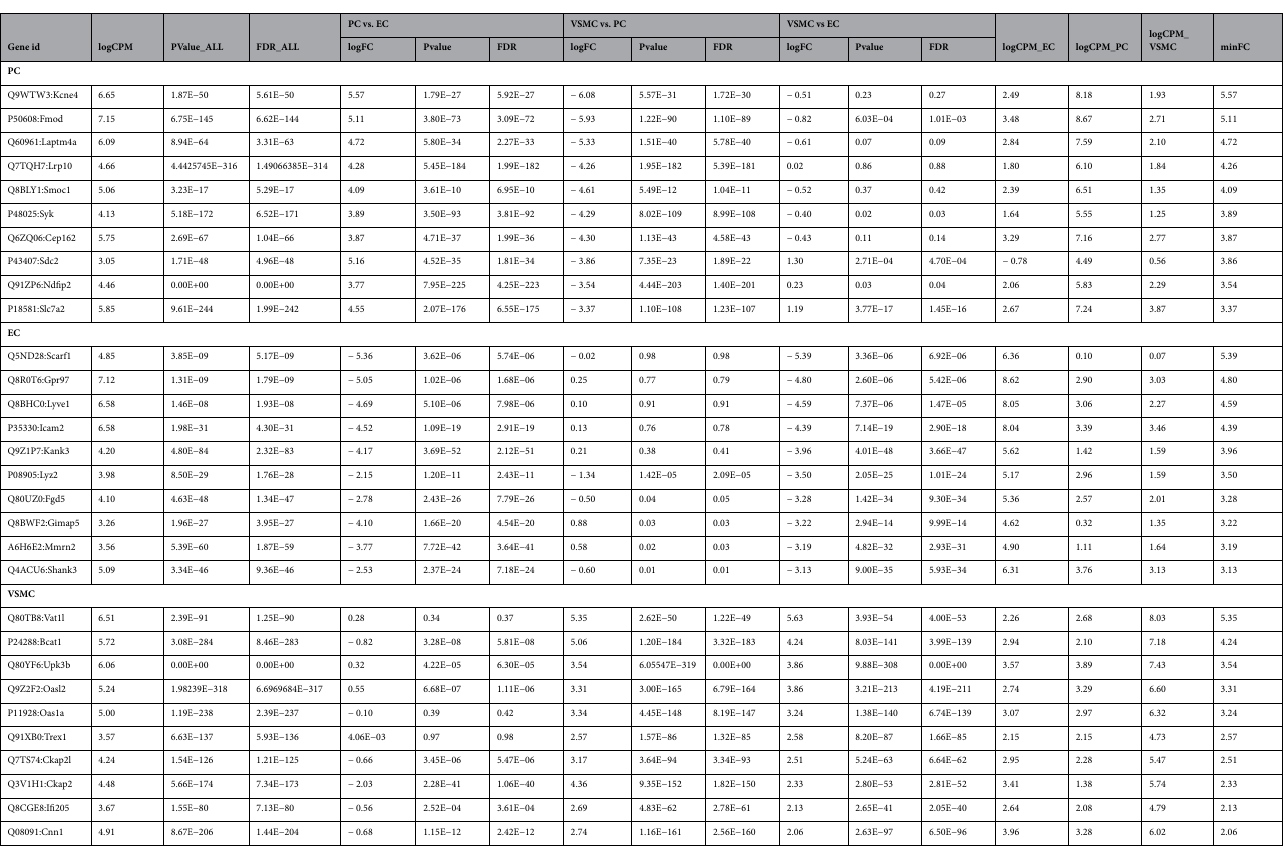
Table 1. Top 10 novel protein markers for ECs, PCs, and